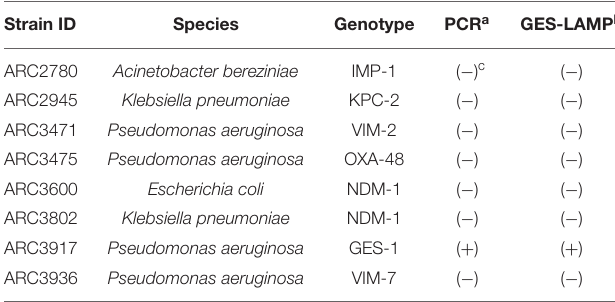
TABLE 1 | Reactivities and specificities of PCR and LAMP assays detecting bla GES